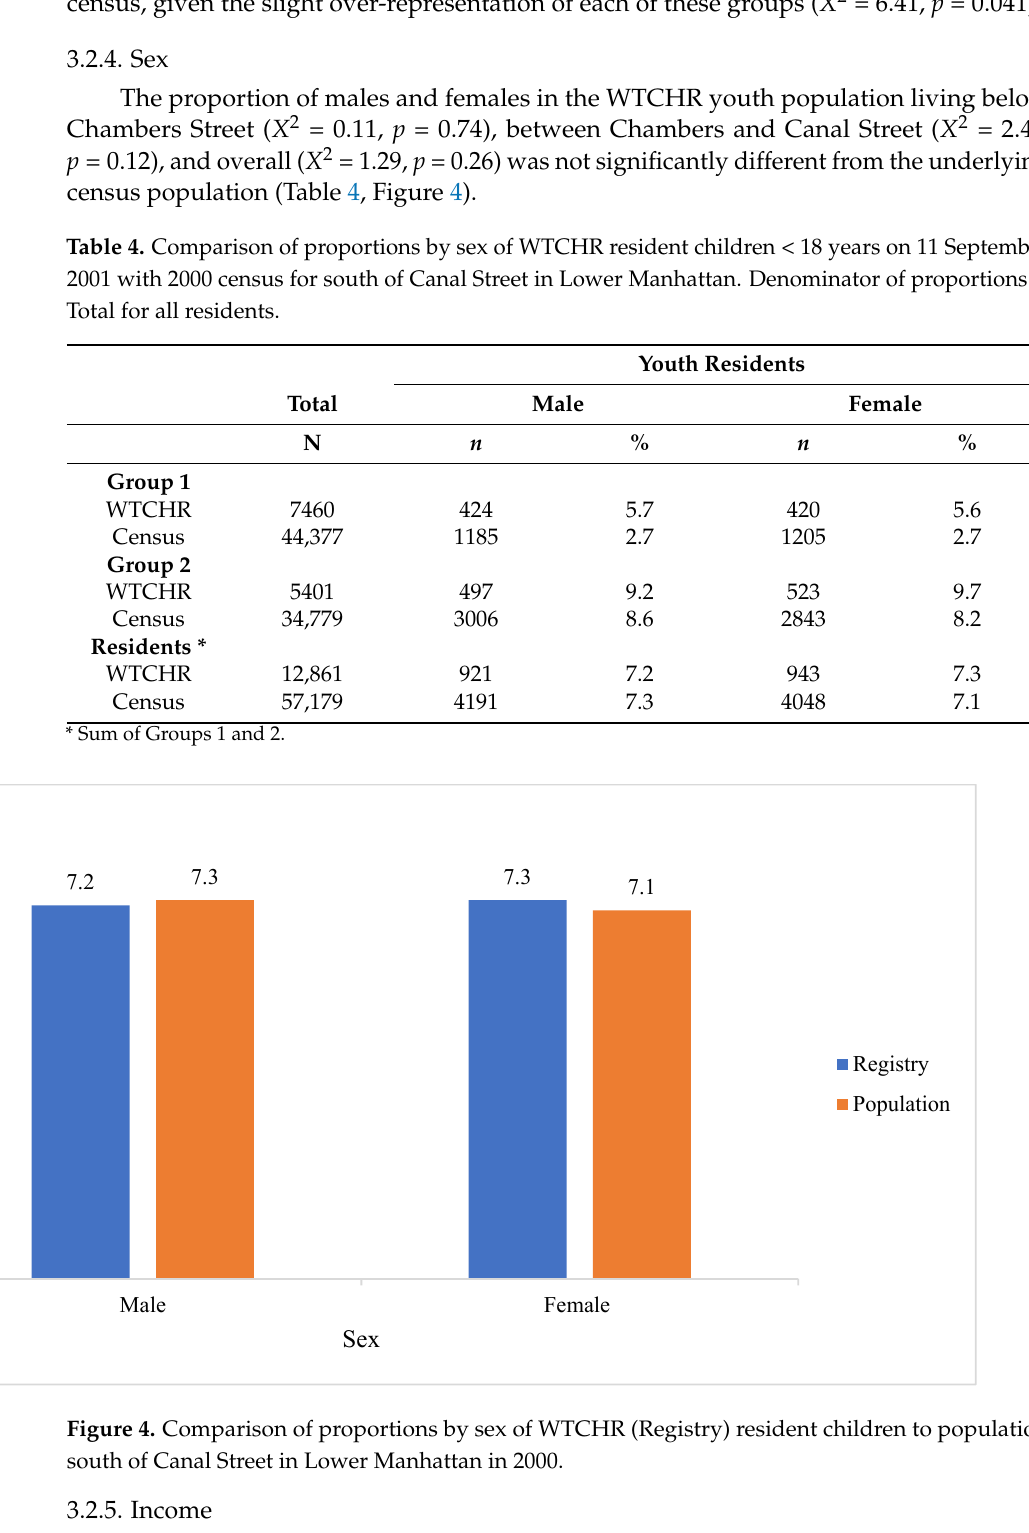
Table 5. Comparison of proportions by annual household income of WTCHR residents on 11 Sep- tember 2001 with 2000 census for south of Canal Street in Lower Manhattan. Denominator of pro- portions is Total for all residents. Income Group (Annual Household Income)